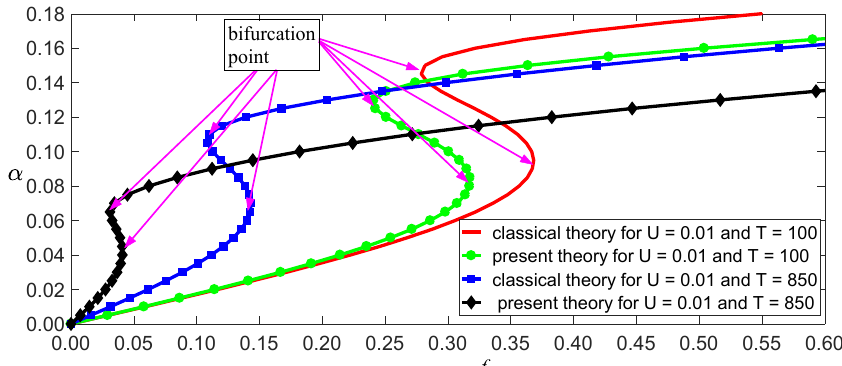
Figure 7. Load–response curves of vibration amplitudes with two temperatures for ( c , σ , U ) = ( 1, 3, 0.01 ) .